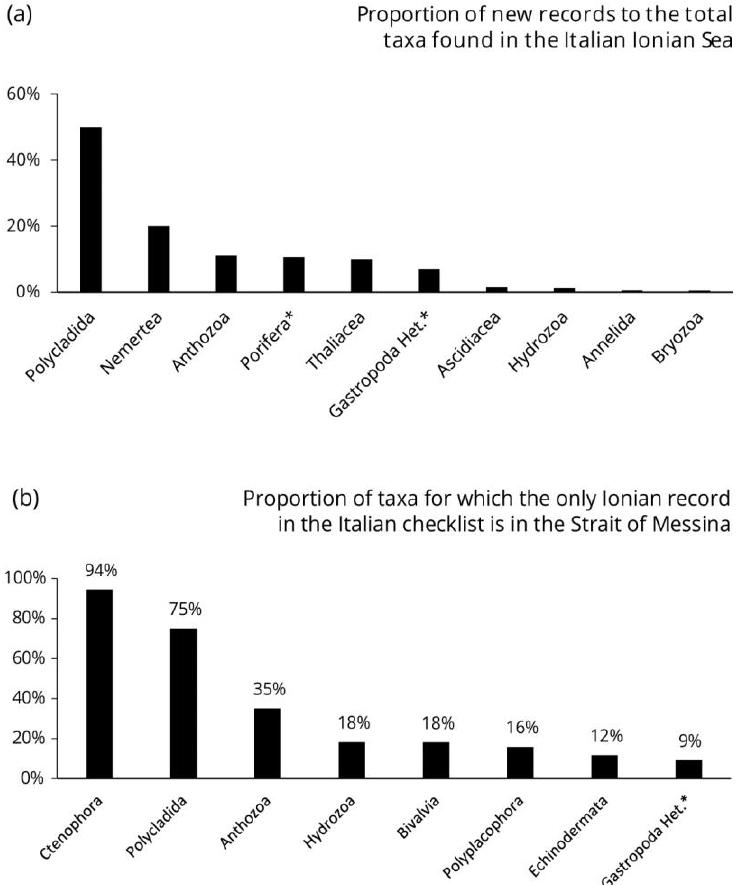
Figure 6. Comparison with the check list of the Italian marine fauna [60,61]. ( a ) Percentage proportion of new records found by this study to the total taxa reported in the Italian Ionian Sea by Relini [60,61]. ( b ) The proportion of taxa for which the only Ionian record in Relini [60,61] comes from the Strait of Messina biogeographic sector. Het., Heterobranchia. * indicates taxonomic groups that have already been included in previous publications [30,33].